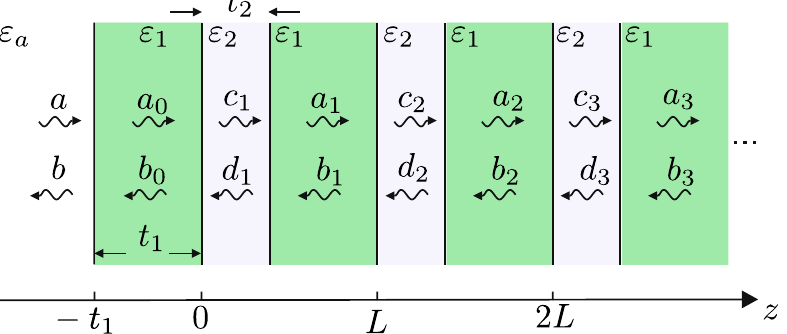
Figure 6. Schematics of the heterointerface geometry. It is obtained from the homointerface geometry in Fig. 4 by replacing the semi-infinite ε 1 medium with a semi-infinite medium ε a extending from left infinity up to z = − t 1 , so that the structure remains invariant for z > − t 1 . In the text we show that the TPM properties are determined by a combined interaction of the newly added ε a − ε 1 interface at z = − t 1 and the homointerface at z = 0 buried under the top ε 1 layer of the